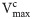
The time dependence of 6 different quantities that are measured for gluten (as defined in section 1 of the S1 Text) during the elongation in the last stage of the simulation.The solid blue (orange) lines correspond to the quantities listed along the left (right) y-axis. The lines are smoothed, solid (hollow) dots represent raw data from simulation. The quantities analyzed are: the number of inter-chain contacts ninter and the average distortion parameter w, force F and work W, the maximum volume of a cavity Vmaxc and the number of cavities nc. The 4 snapshots (similar to those on Fig 1, but in the ortographic projection) correspond to the displacements s written above them and marked by the arrows. The same coordinate system (defined in the top left) is used for all snapshots. The biggest cavity is outlined by a pink mesh.